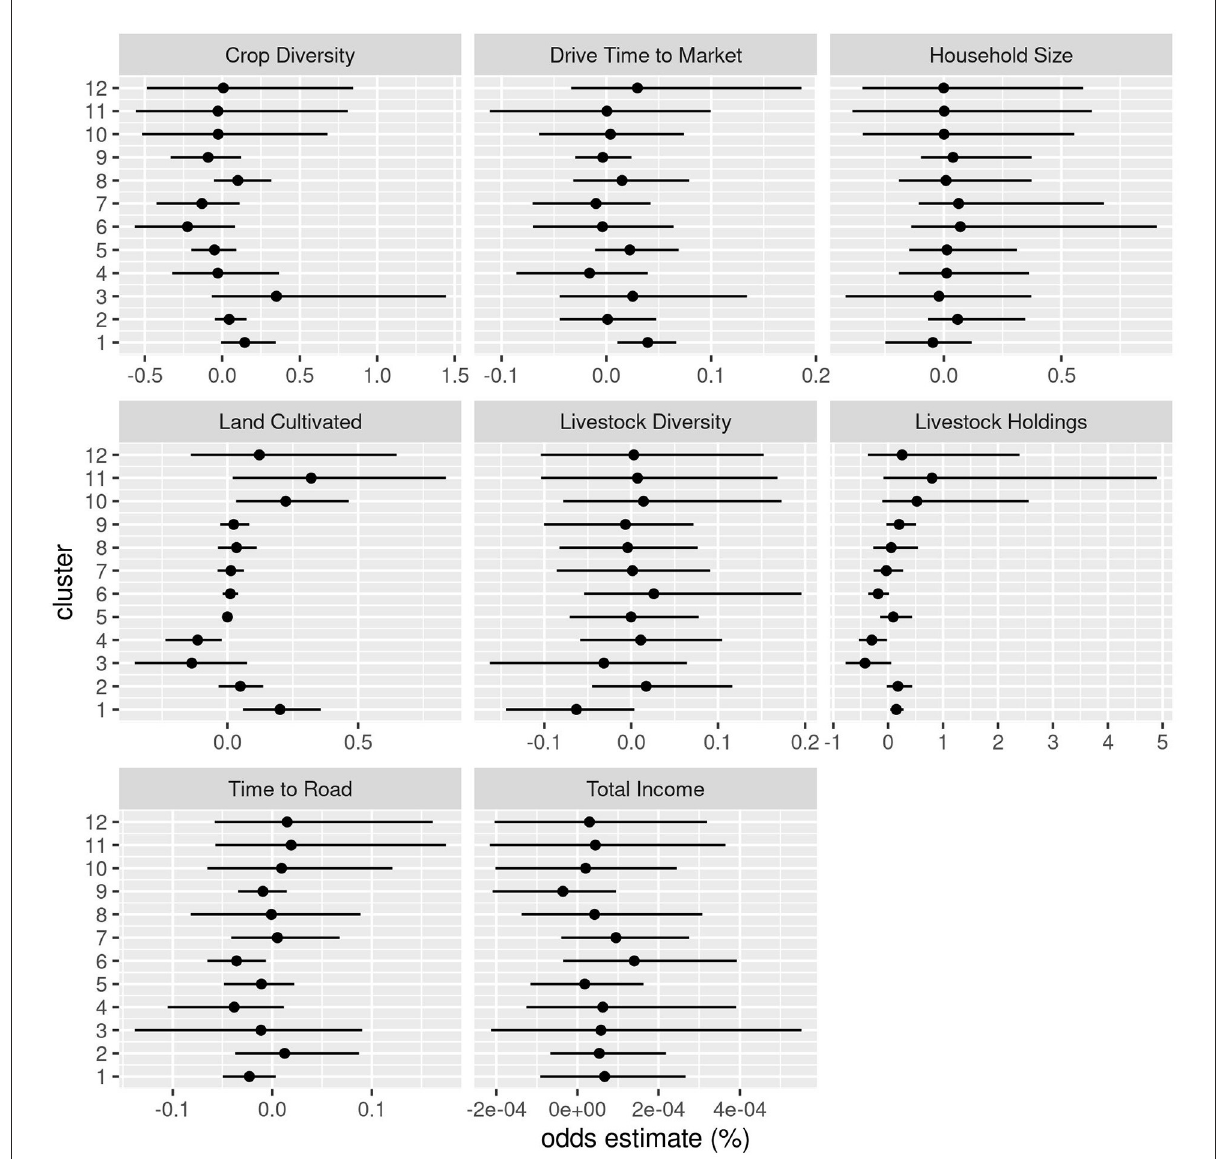
FIGURE3 Distribution of odds of change in Household Dietary Diversity Score given an increase of one unit in each variable for each cluster. Bars not intersecting with zero denote statistically significant results. The italic values indicate the confidence intervals and provide guidance on the significance of model